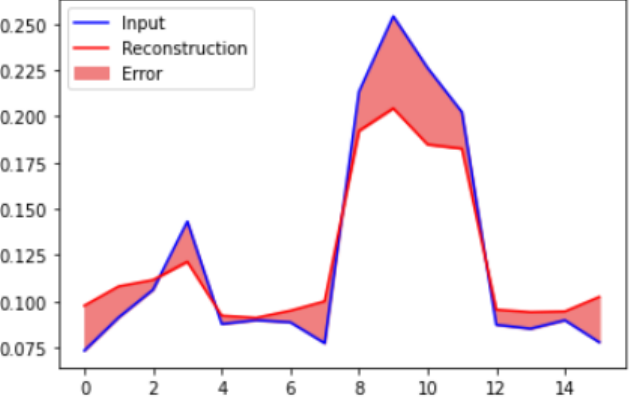
Figure 13. Reconstruction loss of normal data